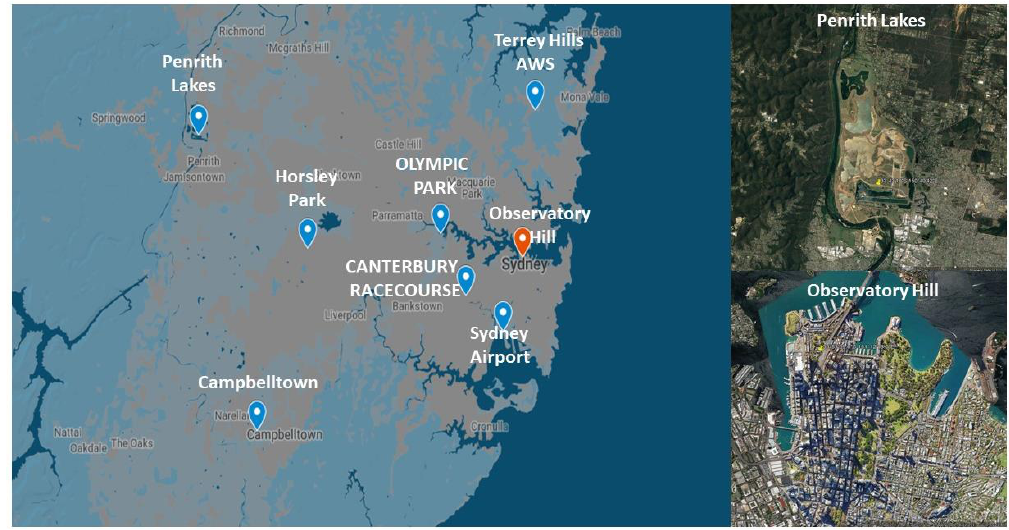
Figure 1. Selected weather stations and their